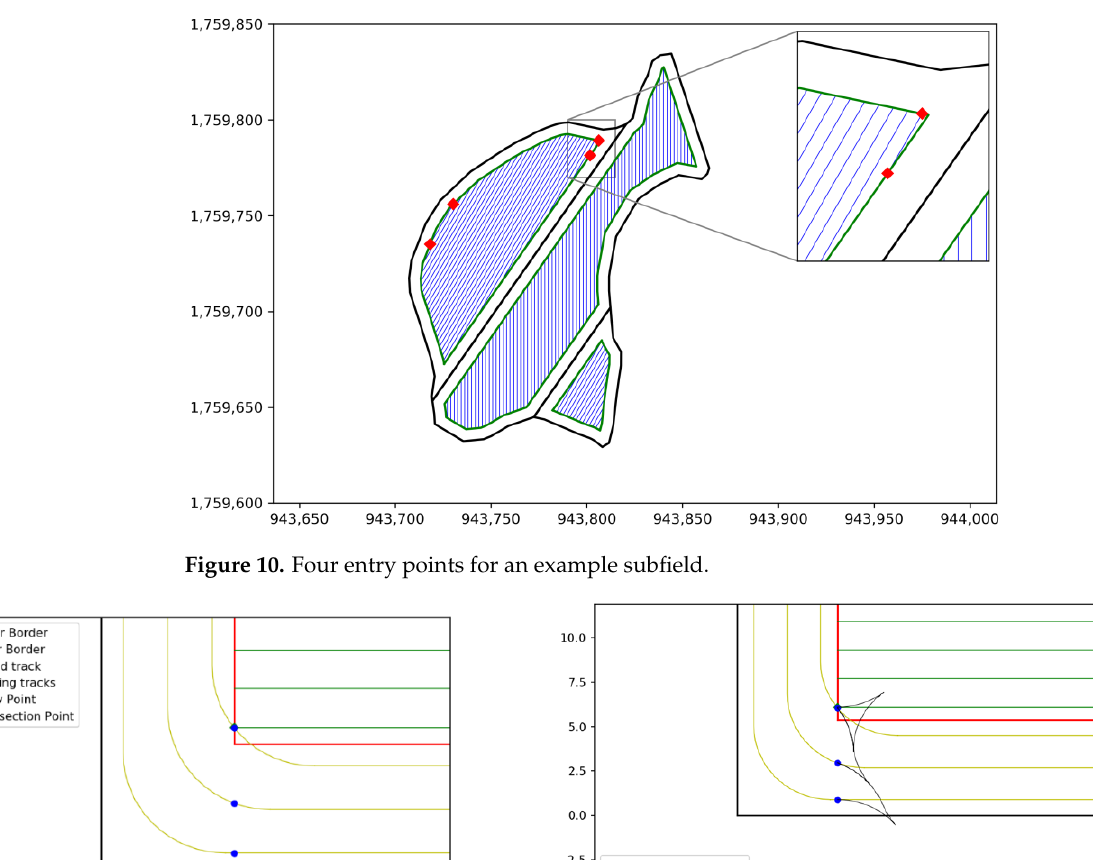
266 267 268 268